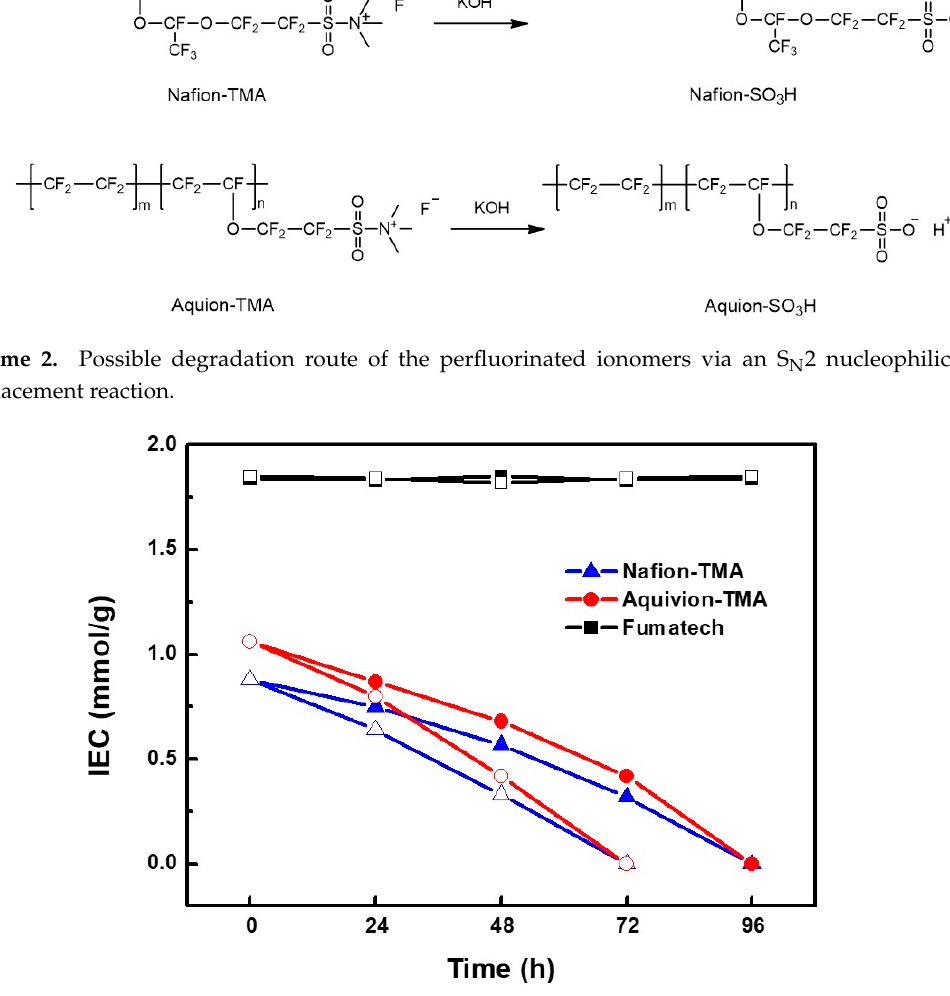
Figure 6. Alkaline stabilities of the Nafion-TMA, Aquivion-TMA, and Fumatech membranes in 0.5 (solid) and 1.0 M (open) NaOH solutions at 25 °C.